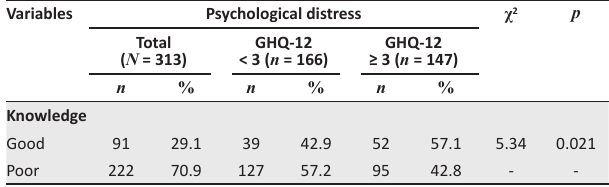
GHQ, General Health Questionnaire.